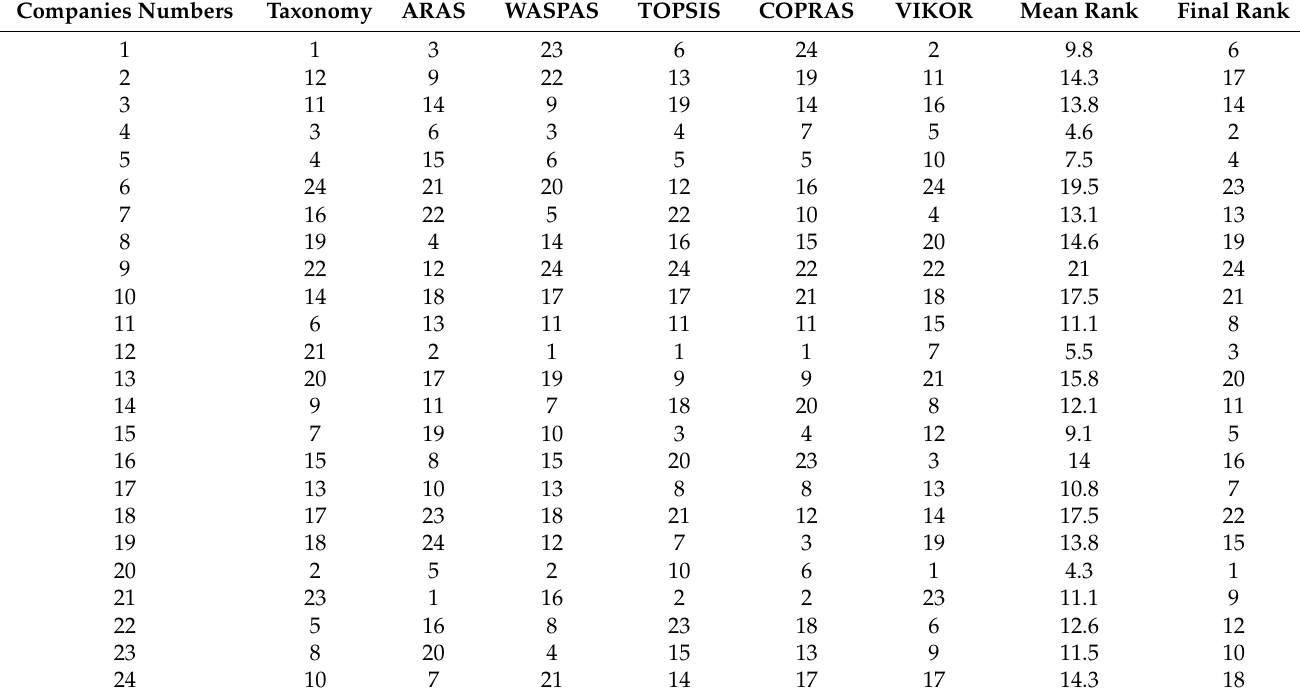
Table 3. Combined results according to mean rank method.